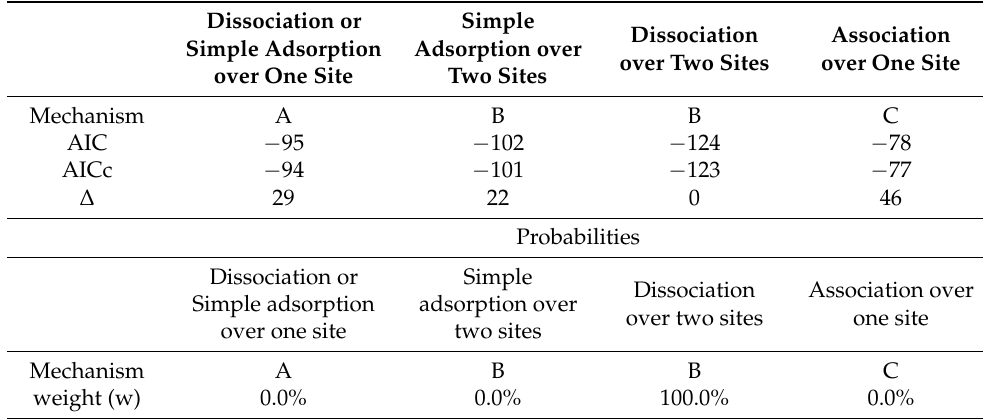
Simple adsorption over one site